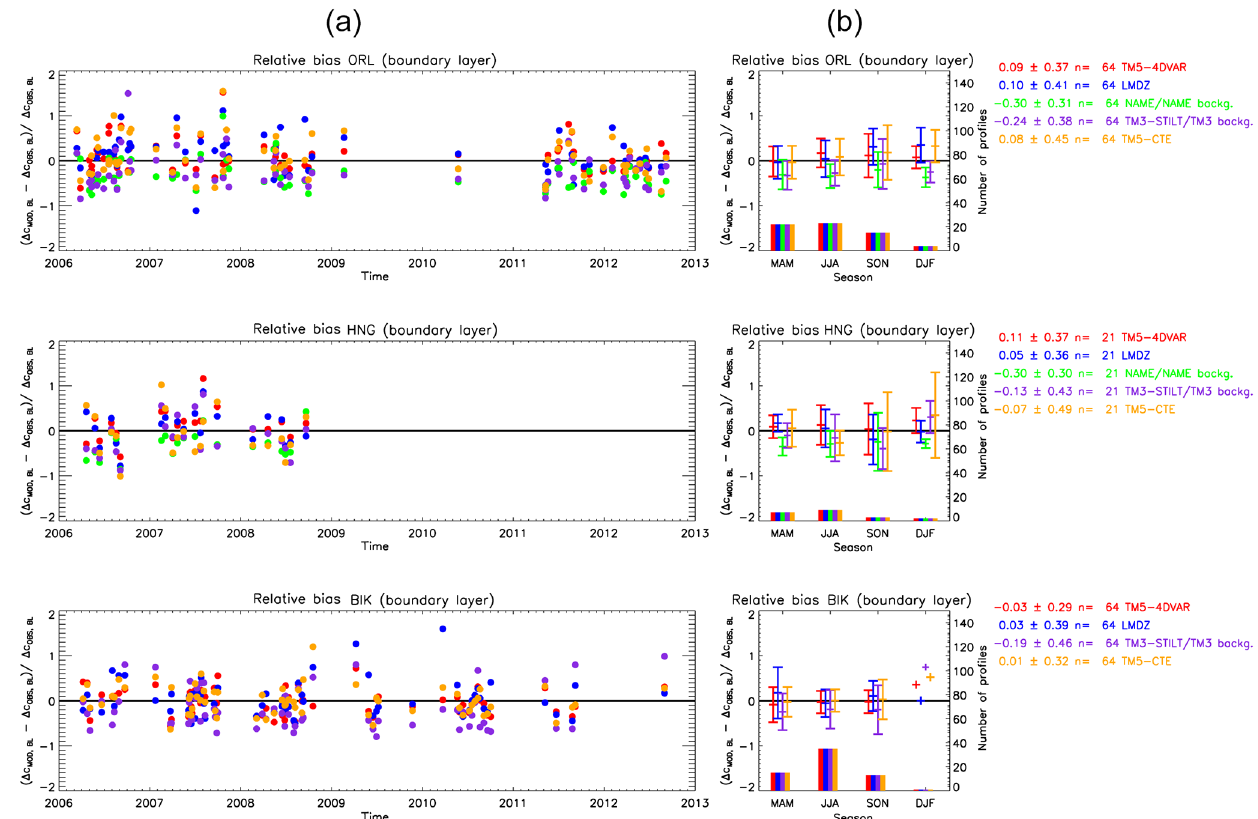
Figure 6. Relative bias within the boundary layer evaluated from simulated and observed CH 4 mole fraction enhancements compared to the background (rb BL = ((cid:49)c MOD , BL − (cid:49)c OBS , BL )/(cid:49)c OBS , BL ) ; see Sect. 4.2). For NAME the model enhancement has been evaluated using the NAME background, for TM3-STILT using the TM3 background, while for all other models the TM5-4DVAR background is used. (a) Time series; (b) seasonal averages (including 1 σ standard deviation) with numbers of available profiles given as bar graphs (see right axis). The numbers on the right side are the average relative bias, 1 σ standard deviation, and total number of profiles over the entire